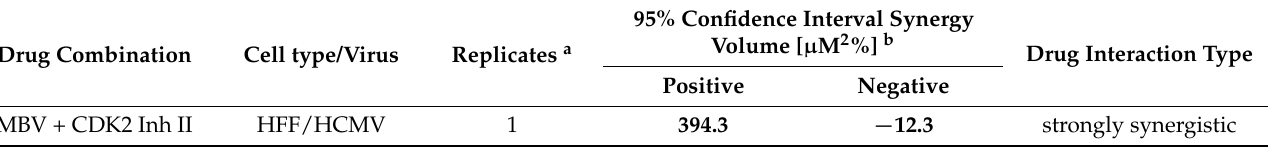
Table 6. Combinatorial anti-HCMV drug assessment using the Bliss independence checkerboard assay.